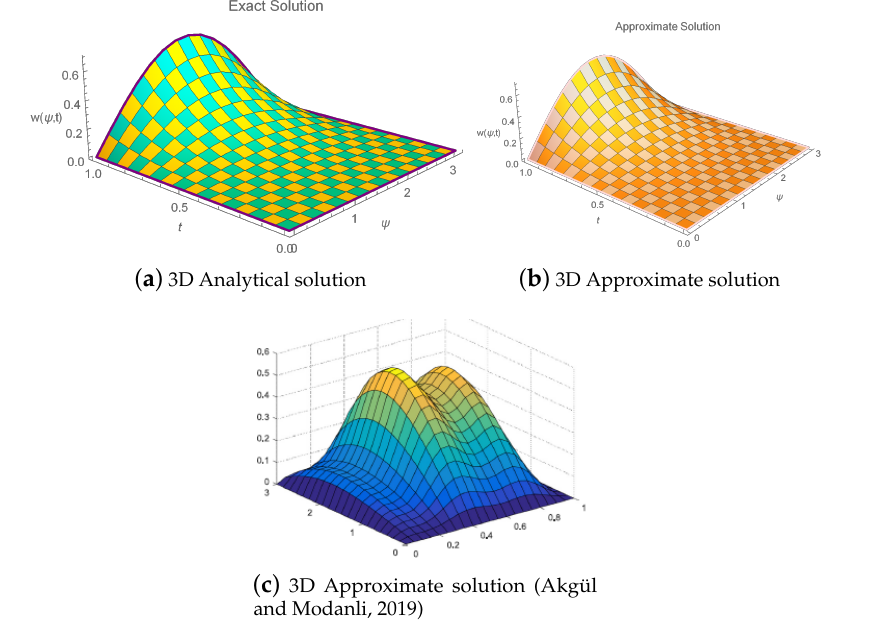
Figure 4. Comparison between 3D analytical, proposed approximate, and approximate [10] solutions of example 1 for γ = 0.69 and ˜ M = K = 20.